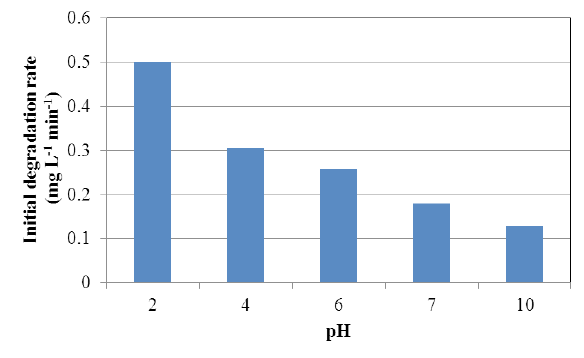
Figure 6: Initial degradation rate of AB25 at various pH values in the presence of 0.5 g. L -1 of TiO (treated volume 500 mL, initial dye 2 concentration 20 mg L -1